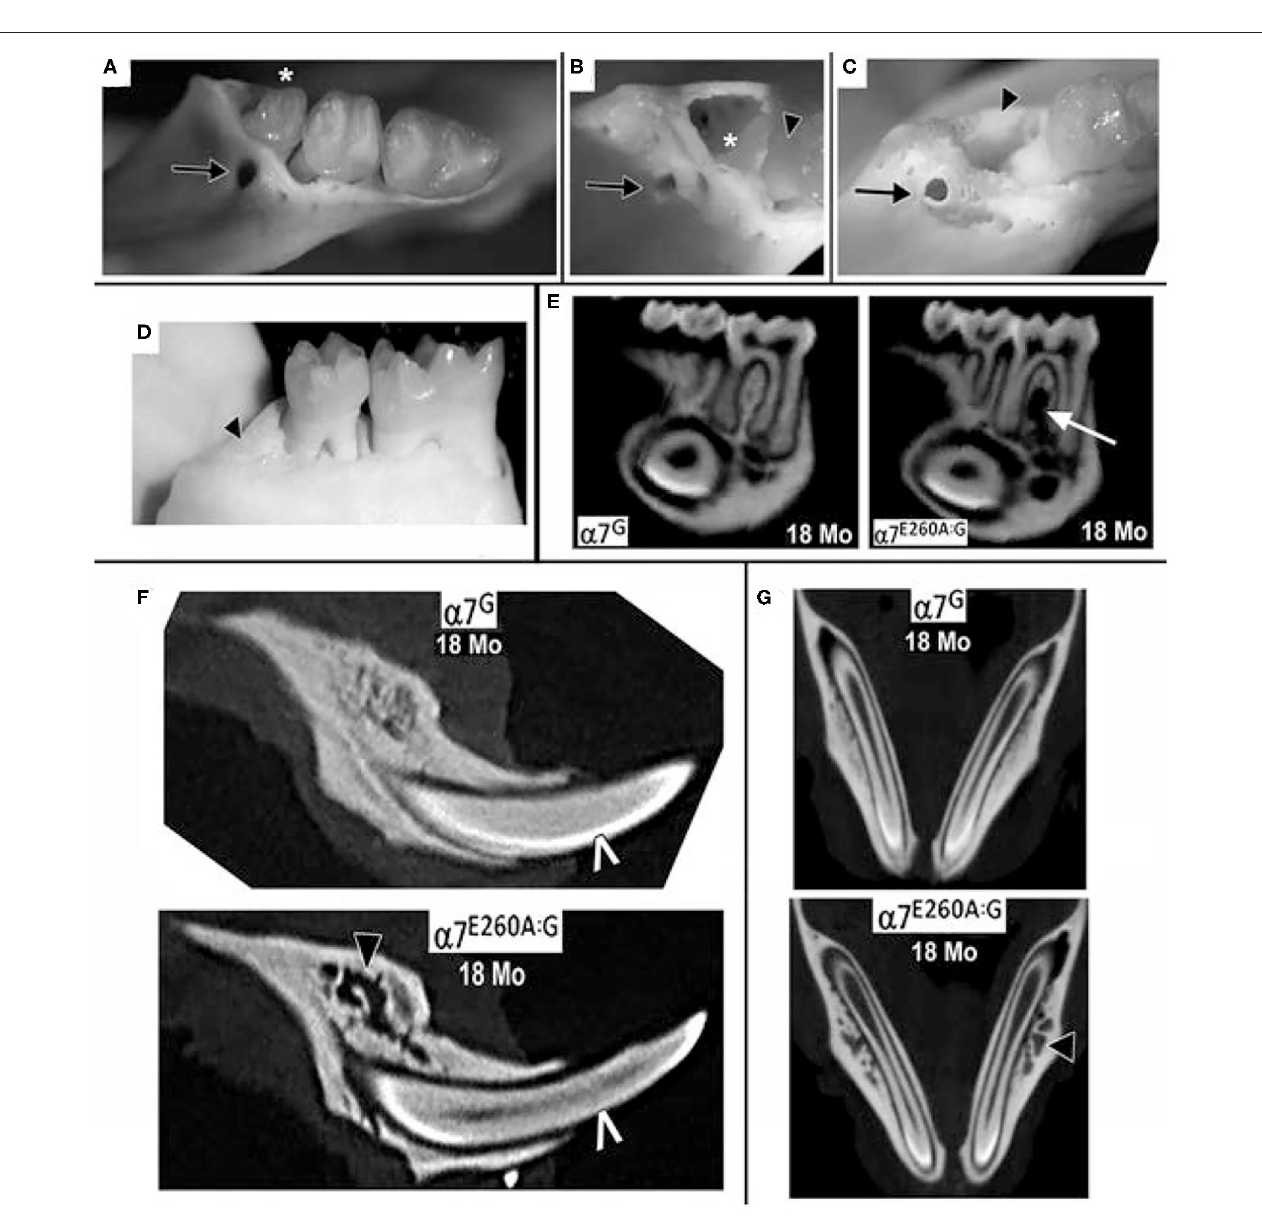
FIGURE 2 | Extensive loss of 3rd molars and local bone loss in the 18 month old α 7 E260A : G mice mandibles. (A) Example of a loose 3rd molar tooth (asterisk) that upon defleshing reveals additional bone abnormities (arrow). (B) Another mandible that was missing the 3rd molar prior to defleshing also exhibits bone abnormities (arrow), the socket of the missing 3rd molar (asterisk) and a root of the adjacent 2nd molar (arrowhead). Also, note the porous appearance of the surrounding bone. (C) Another example of a bone abnormality (arrow) and the socket of a missing 3rd molar (arrowhead) and exposed root of the 2nd molar. (D) An example of a missing 3rd molar where the socket is filled with relatively smooth solid bone-like deposits (arrowhead). (E) Sagittal virtual micro-CT view of mandibles from 18 month old mice showing the loss of dense bone material between the roots of the α 7 E260A : G first molar (arrow). (F) A similar sagittal view shows that bone abnormalities extend to other mandible bone regions (black arrow head). The white pointer identifies CT-bright enamel. (G) Horizontal micro-CT sections showing the extensive porosity of the bone surrounding the α 7 E260A : G incisors (black arrow head) when compared to the control.